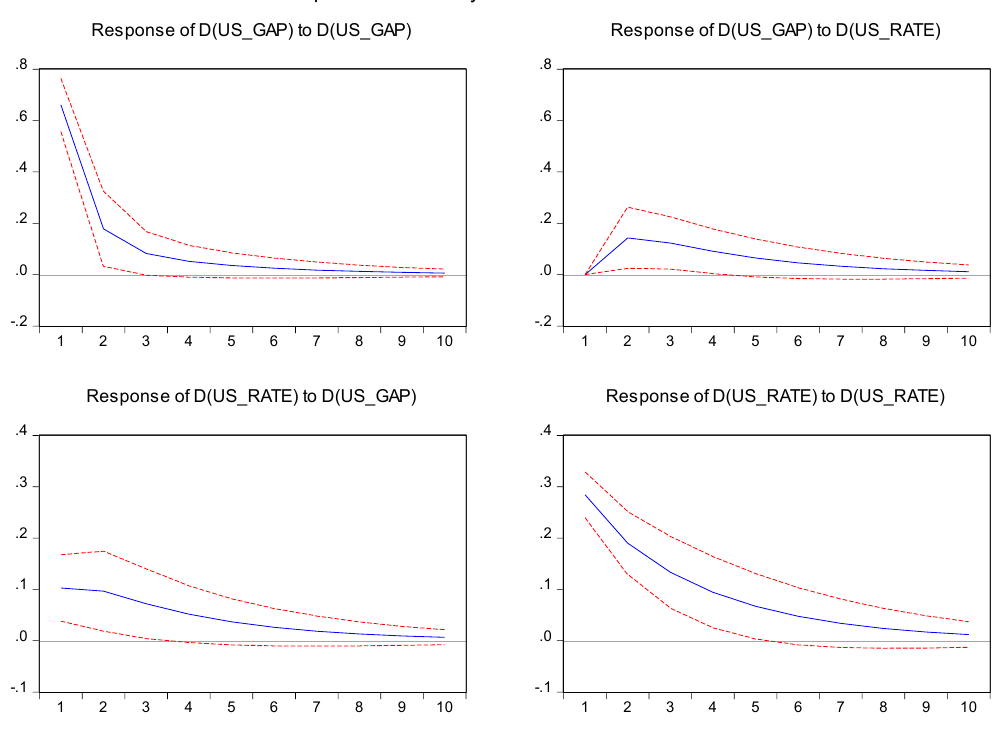
Figure 6. Impulse functions for the